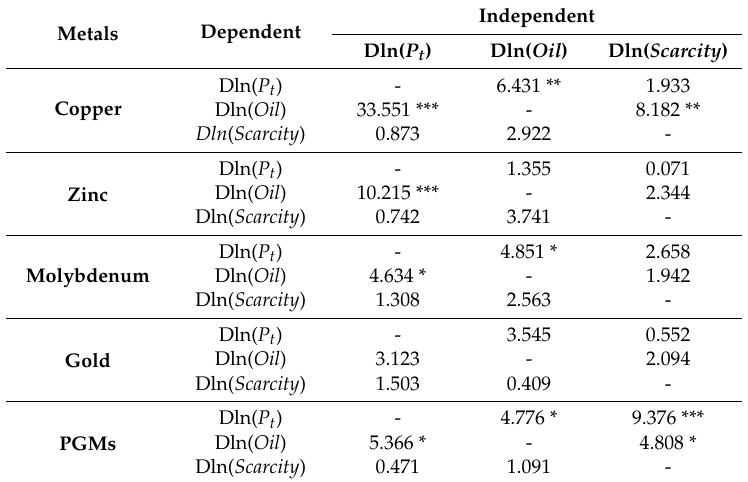
Table 3. Results of Granger causality (Wald) tests of metals, crude oil prices and scarcity.